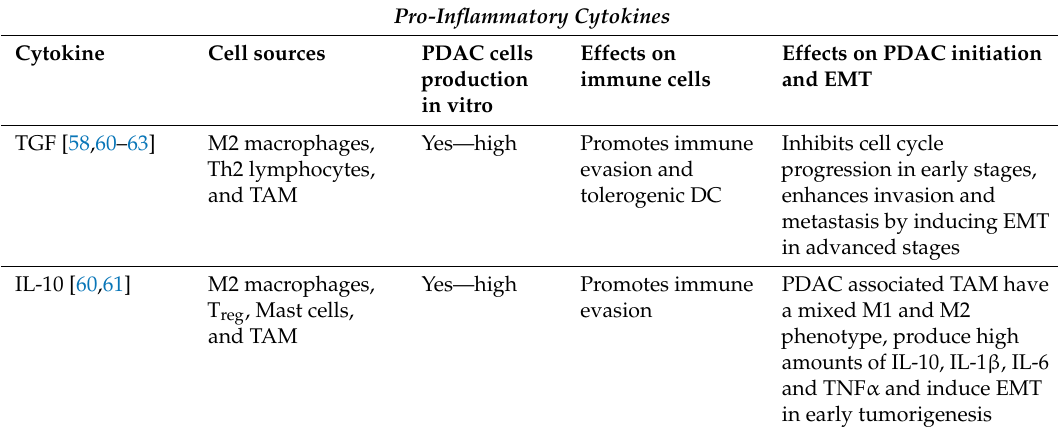
Table 1. Cytokines in pancreatic